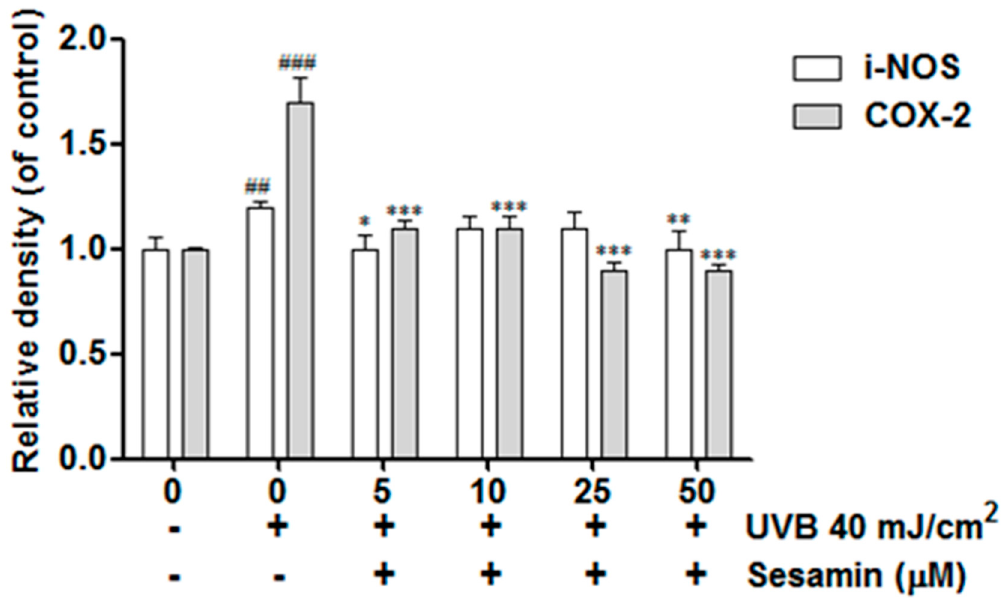
Figure 9. Sesamin inhibited the UVB induced inducible nitride oxide synthase (i-NOS) and cyclooxygenase (COX-2) in human skin fibroblasts. ## p < 0.01; ### p < 0.001: Significant difference versus non-irradiation group. * p < 0.05; ** p < 0.01; *** p < 0.001: Significant difference versus non- treatment group.